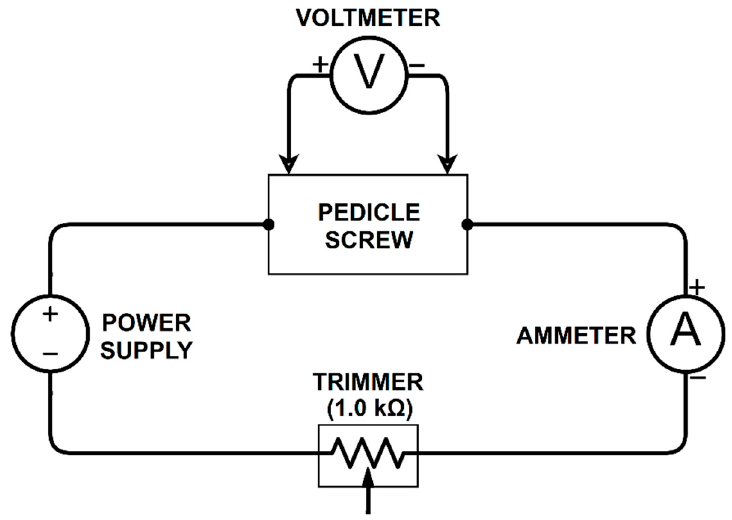
Figure 2. Schematic of the testing circuit designed to measure the pedicle screw